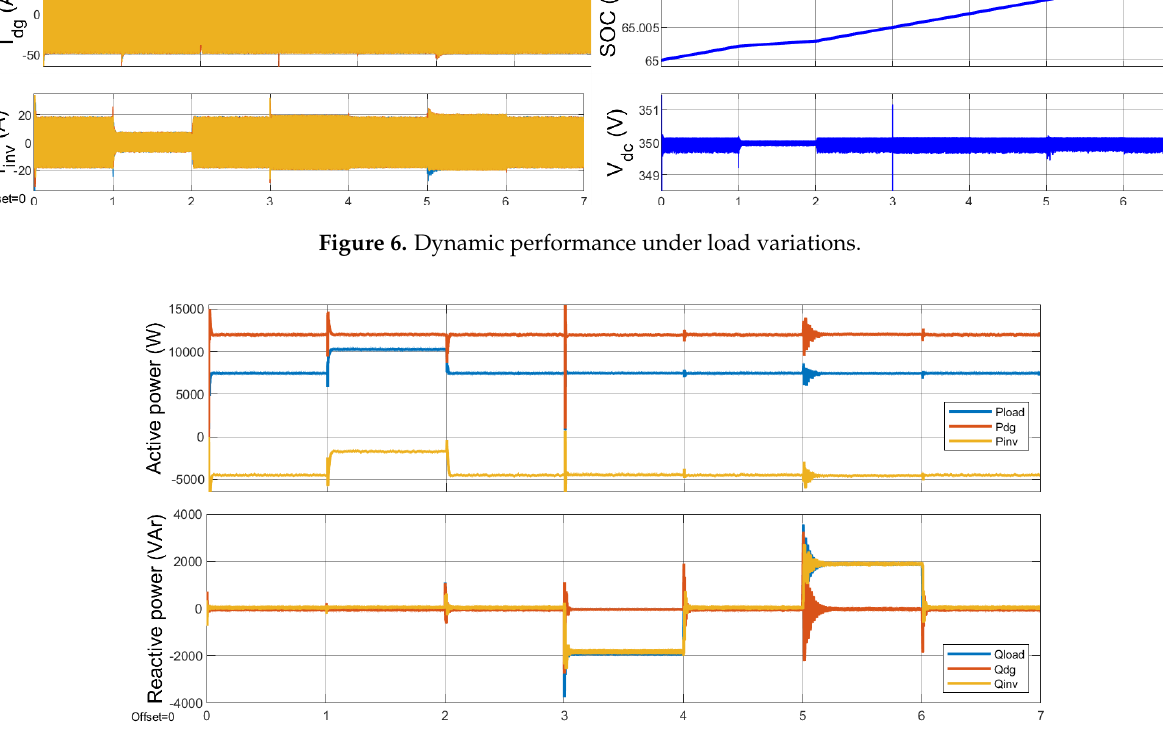
Figure 7. Active and reactive power of the load, DG, and inverter.